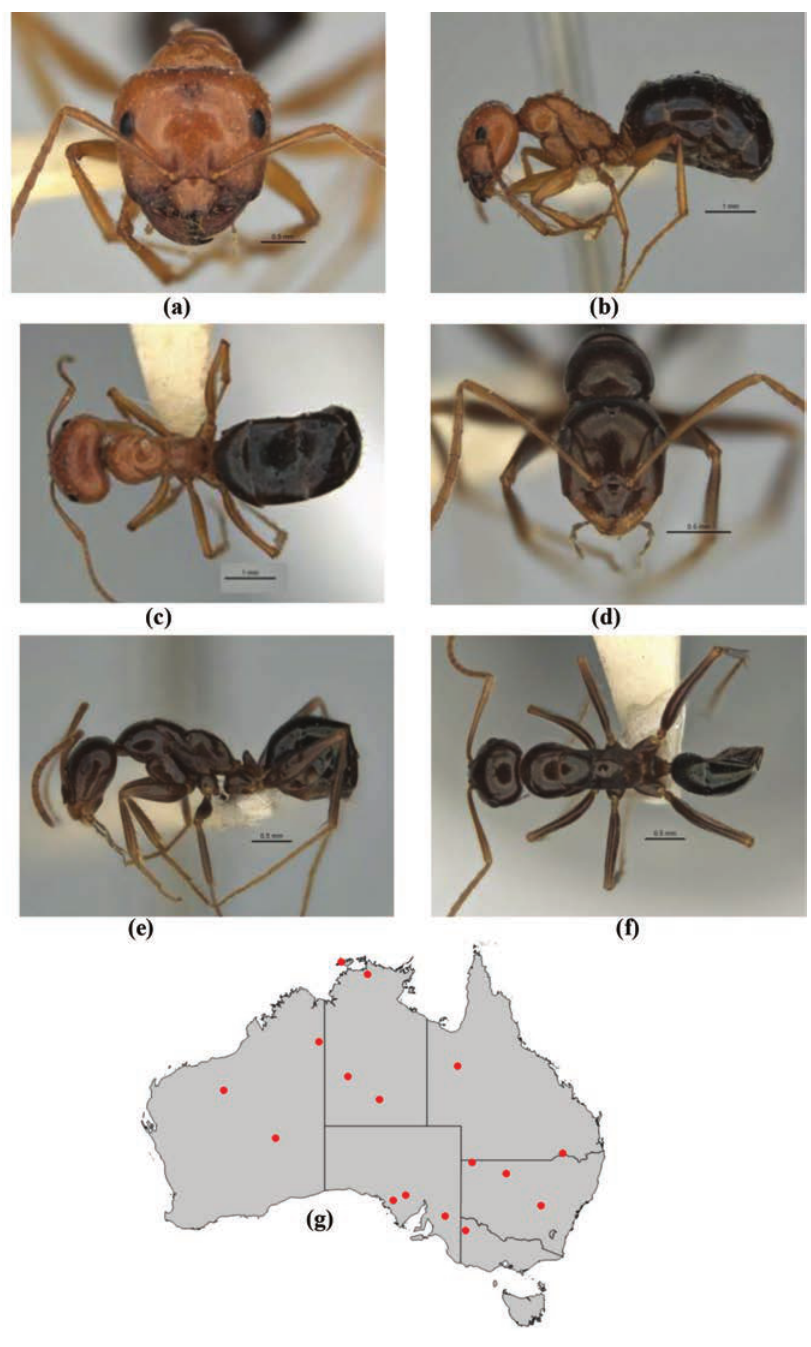
Figure 9. Melophorus castaneus sp. n.: major worker paratype (ANIC32-900180–top ant) frons ( a ), pro- file ( b ) and dorsum ( c ); minor worker holotype (ANIC32-900180–bottom ant) frons ( d ), profile ( e ) and dorsum ( f ); distribution map for the species ( g ). Low resolution scale bars: 1 mm ( b, c ); 0.5 mm ( a, d–f